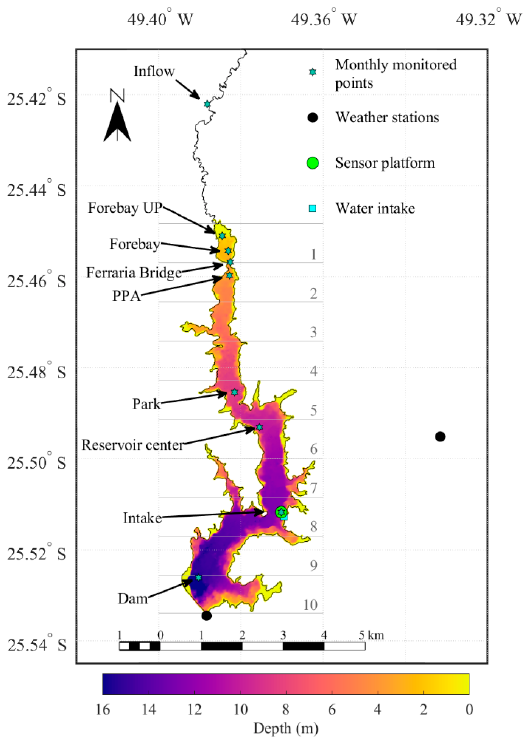
Figure 1. Map of Passaúna Reservoir. The color map shows the reservoir bathymetry (adopted from Sotiri, et al. [28]); the location of the dam, the intake station, and the main river inflow are indicated by text labels. Symbols mark the location of sampling sites for continuous sensor observations and monthly water quality sampling (see legend). The latitudinal sections (numbered as 1 to 10) are used in the spatial analysis of model simulations and remote sensing data.